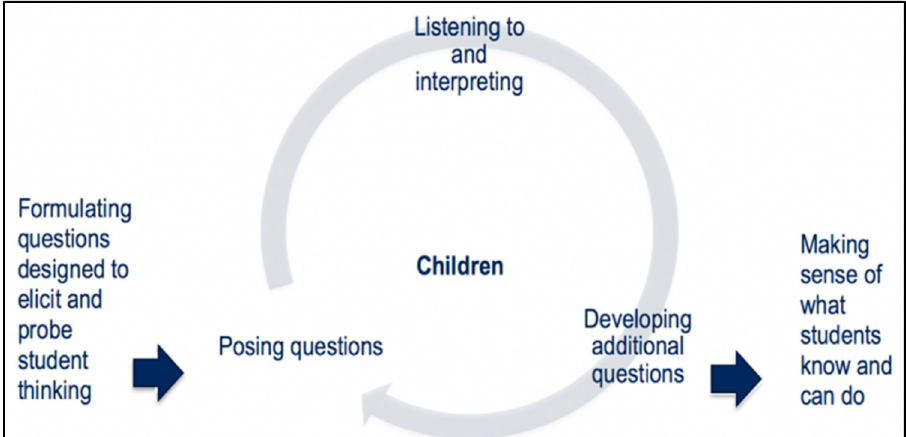
Figure 1. Decomposed components of eliciting and interpreting student thinking [43,45]. Note. From Eliciting and Interpreting Student Thinking (Image), by TeachingWorks. CC BY-NC 3.0.